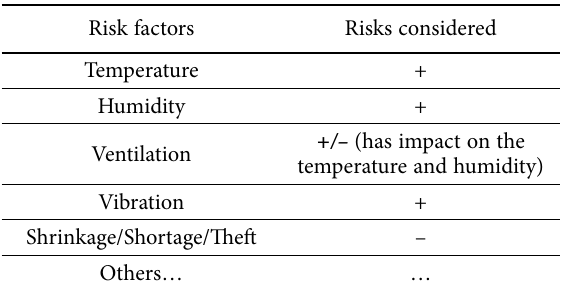
Table 2. Risk factors